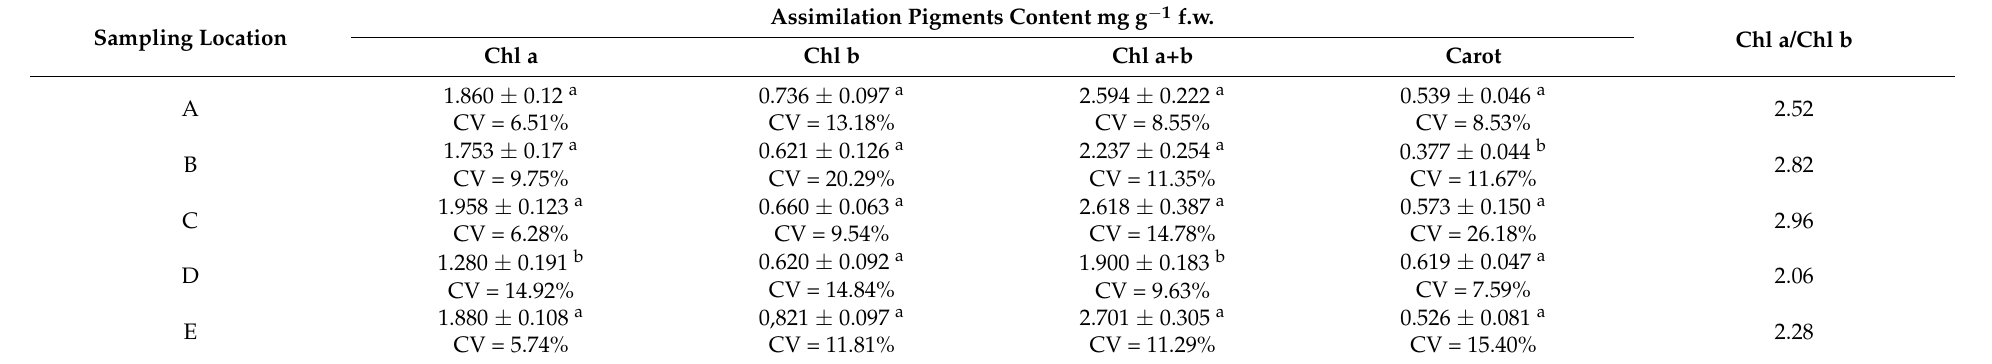
Table 4. Content of chlorophyll a (Chl a), chlorophyll b (Chl b), chlorophyll a+b (Chl a+b) and carotenoids in pine needles. (mg g − 1 f.w.) of the Bydgoszcz agglomeration area. Sampling